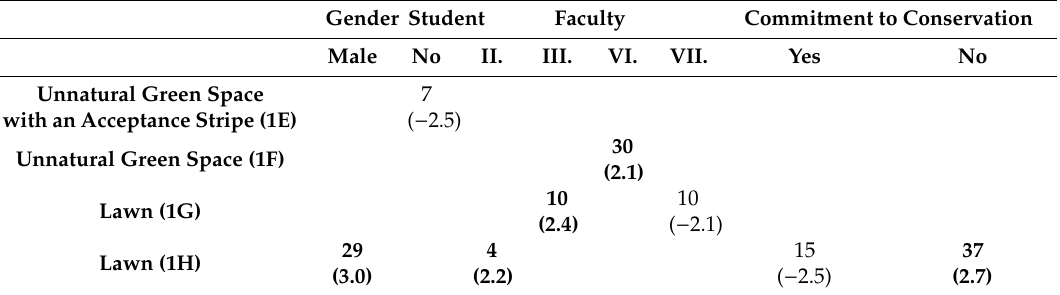
Table 2. Question 1 compared natural early summer meadows with unnatural green spaces (1E and 1F) and lawns (1G and 1H). The meadows and unnatural green spaces were illustrated with (1E) and without (1F) an acceptance stripe. The table presents the number of choices for a certain green space by the respective sociodemographic group (standardized residuals in brackets). Whereas a positive residual indicates that the scenario was appreciated by the relevant demographic group (bold type), a negative residual indicates that the scenario was disliked (normal typeface). Only significant cases are listed. Gender Student Faculty Commitment to Conservation Male No II. III. VI. VII. Yes No